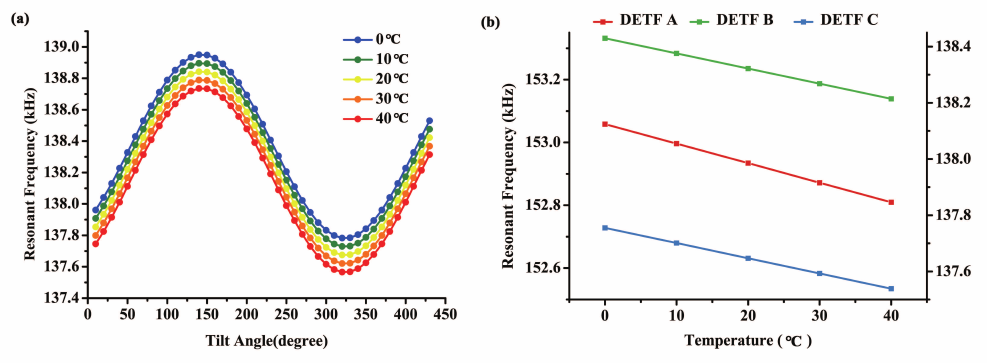
Figure 4. Resonant frequency of DETF B in different temperature environments vs. tilt angle ( a ) and resonant frequency of the three DETFs at a given position vs. temperature ( b ).